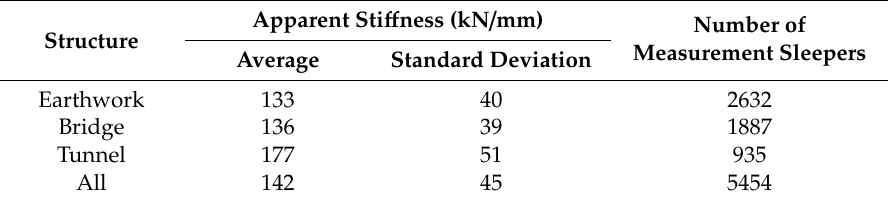
Table 3. Apparent sti ff ness average and standard deviation for supporting sleepers.